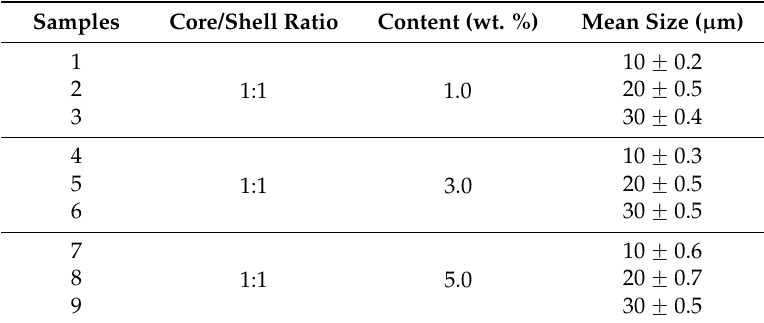
Table 1. The microcapsule/bitumen samples with various